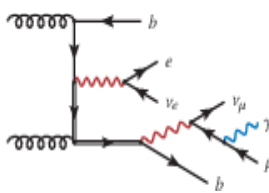
Figure 16. Leading-order Feynman diagram for the tW γ process. Red gauge boson lines represent W bosons while blue gauge boson lines represent photons